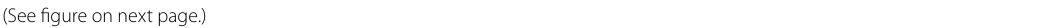
cohort(See figure on next Fig. 3 Comorbidities of myositis patients. A Relative frequencies of comorbidities based on ICD‑10 codes for the entire myositis cohort (total), the myositis subgroups (DM dermatomyositis, PM polymyositis, OM other myositis) and the control population in the BARMER cohort according = = = to sex. B Relative frequencies of neoplasms in the entire myositis cohort over the age of 65 compared to the control population in the BARMER cohort. C Relative frequencies of neoplasms in the entire myositis cohort under the age of 65 compared to the control BARMER